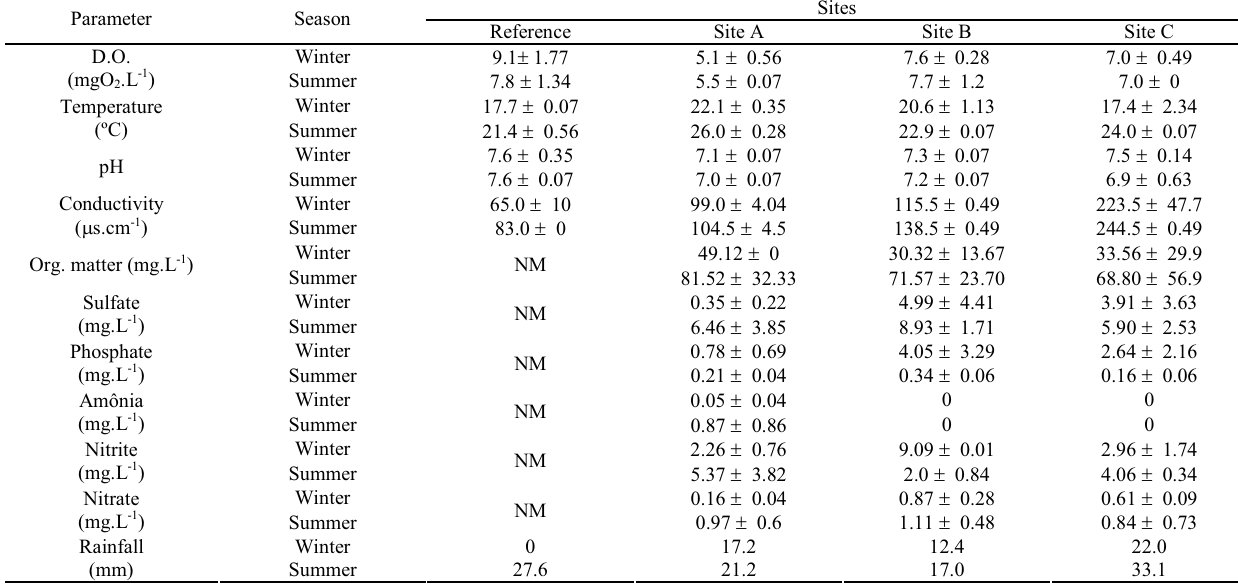
Table 1. Average data of physical - chemical parameters of water from study sites at the beginning and the end of the caging period. Values are mean ± S.E., excepting rainfall values, which correspond to the sum of the 3 days before and the 7 days caging period. NM = not